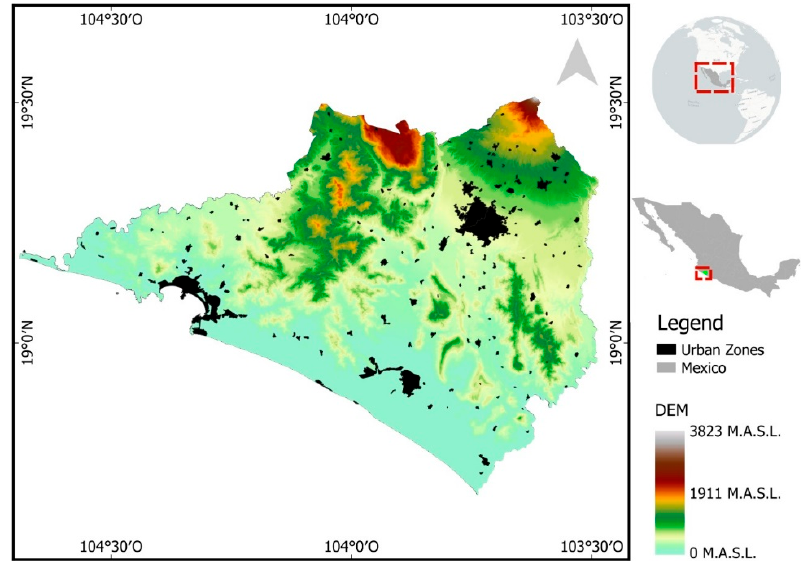
Figure 1. Study site. Colima, Mexico.